Question: In one sentence, what is this figure communicating?
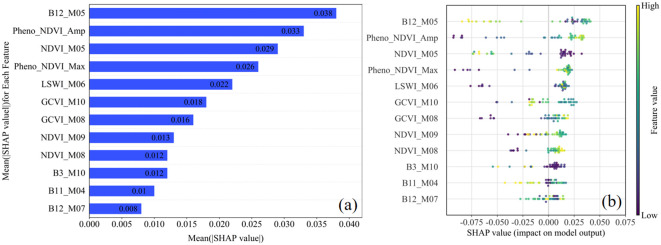
Answer: SHAP-based interpretation of feature importance for Random Forest model. (A) Global feature importance ranking, computed as the mean absolute SHAP value across all samples. (B) SHAP beeswarm plot, showing the distribution of SHAP values for each feature and their influence on model predictions, with points color-coded by feature value (purple: low; yellow: high).